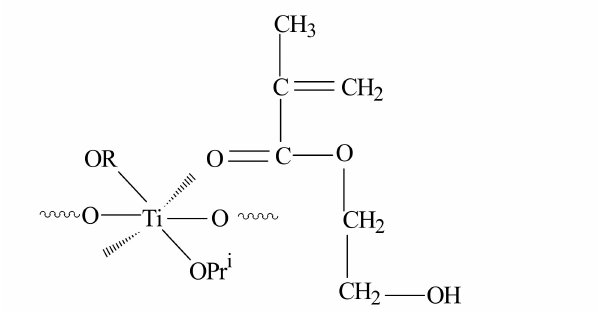
Figure 2. The complex interaction, where OPr i is the alkoxide